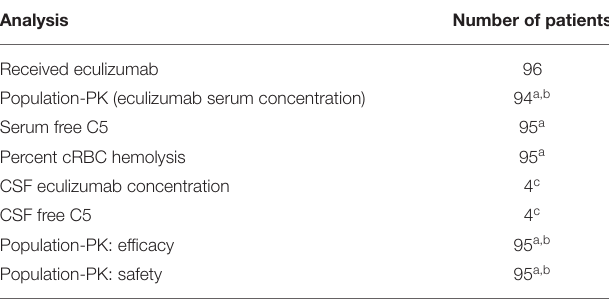
TABLE 1 | Numbers of patients with data available for the